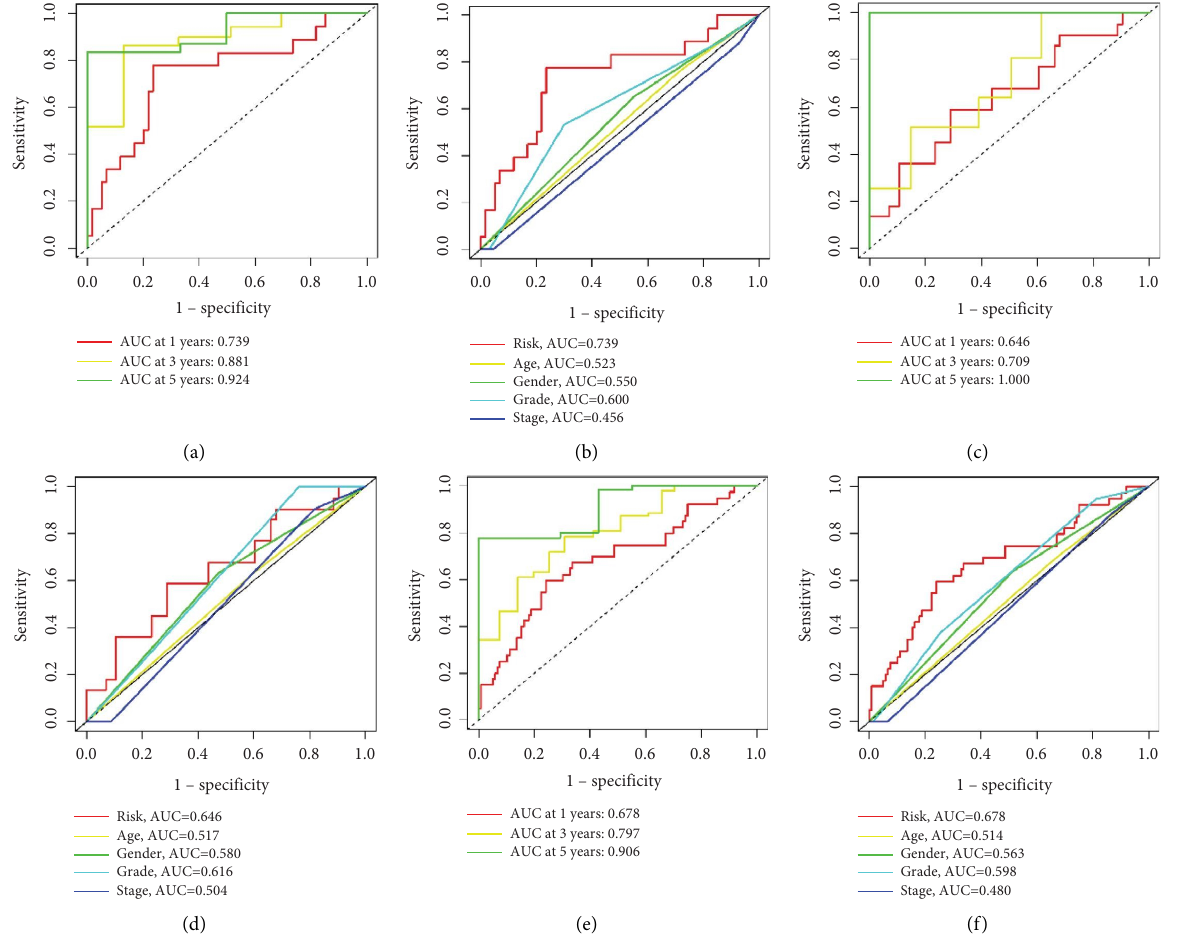
Figure 4: ROC analysis of the sensitivity and specifcity of OS for cuproptosis-related lncRNAs in pancreatic cancer. (a, b) Training set. (c, d) Validation set. (e, f) Entire cohort.